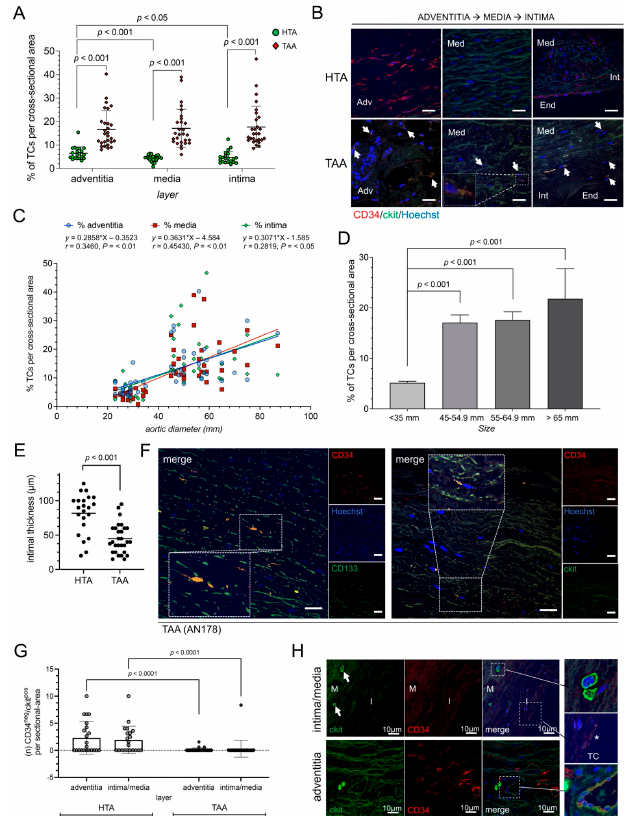
Figure 1. Human aneurysmal tissue showed an increase of TCs and EPCs depending on aneurysm size. ( A ) Statistical analysis of TCs per cross-sectional (number of CD34 + /ckit + TCs/number of total cells) in healthy thoracic aortic (HTA, n = 23) or thoracic ascending aneurysm (TAA, n = 29) tissue. Specific layers of aorta are shown. ( B ) Representative image of double-positively TCs in all three aortic layers, adventitia (Adv; on the left), media (Med; in the middle), and transition zone of media, intima (Int), and endothelium (End; on the right), are presented. TCs are indicated by narrows. Magnification shows morphology of a TC in medial layer. Scale bar, 20 µ m. CD34, red; ckit, green; cell nuclei, Hoechst, blue. ( C ) Correlation study through Pearson’s linear regression analysis of the aortic diameter in mm and percentage of TCs per cross sectional area. Location of TCs was separated into adventitial (adv, blue), medial (med, red) and intimal (int, green) layer. R and p values are given on the top. ( D ) Diagram of TCs detected depending on aortic diameter (size in mm) in healthy thoracic aortic (HTA, n = 23) or thoracic ascending aneurysm (TAA, n = 29) tissue. Data are mean ± SD. ( E ) Intimal thickness was reduced in TAA samples ( n = 29) compared to HTA ( n = 23). Intimal thickness is given in µ m. ( F ) Representative images of immunostaining of EPCs (left) located in medial layer were double stained with CD133 (green) and CD34 (red) with TC-like morphology. CD34 + /ckit + TCs staining (CD34, red; ckit, green) is shown on the right. Single immunofluorescence images are presented on the right of each merged image. Nuclei were counterstained with Hoechst (blue). Scale bar, 50 µ m. Statistical analysis in healthy thoracic aortic (HTA, n = 23) or thoracic ascending aneurysm (TAA, n = 29) tissue ( G ) and representative image ( H ) of ckit-positive and CD34- negative HSC-subset detected in human aortic tissue. CD34 − EPCs were analyzed and given for intima/media and adventitia of aortic vessel separately ( G ). ( H ) Immunofluorescence showed ckit + EPCs next to endothelial tube with double-positive TCs. Magnifications present morphological round to oval ckit + EPC (right upon), double-positive TC (*) (right middle), and EPC close to endothelial tube with TCs (right bottom). CD34, red; ckit, green; nuclei, blue